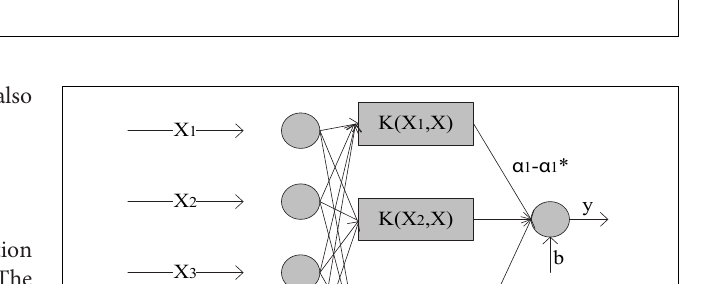
FIGURE 1 | Emotion recognition algorithm structure picture.